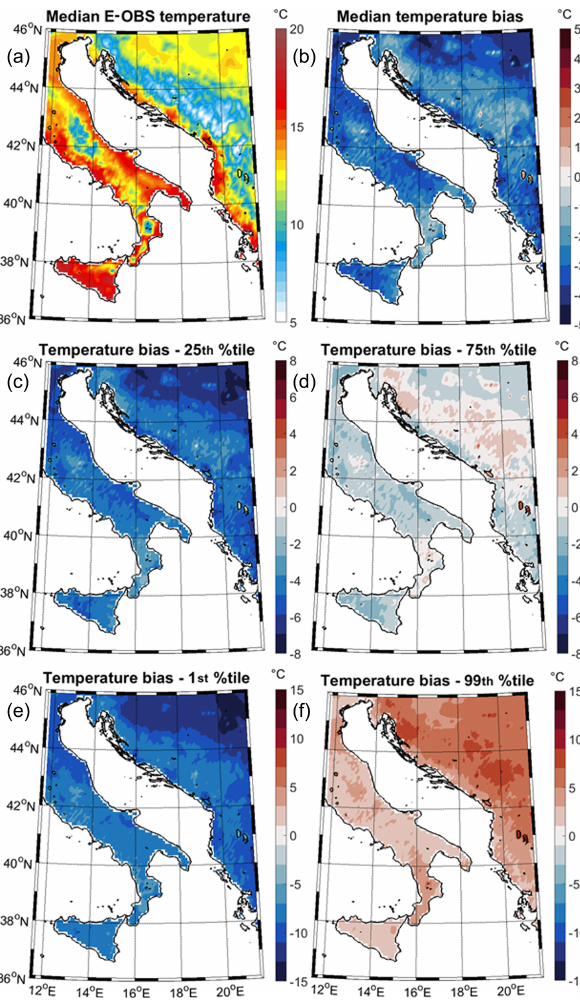
Figure 5. Mean of the E-OBS daily rain dataset over the land (a) and mean (b) and 25th (c) , 75th (d) , 1st (e) , and 99th (f) percentiles of the daily rain biases between AdriSC WRF 3km model results and the E-OBS dataset over the land during the 1987–2017